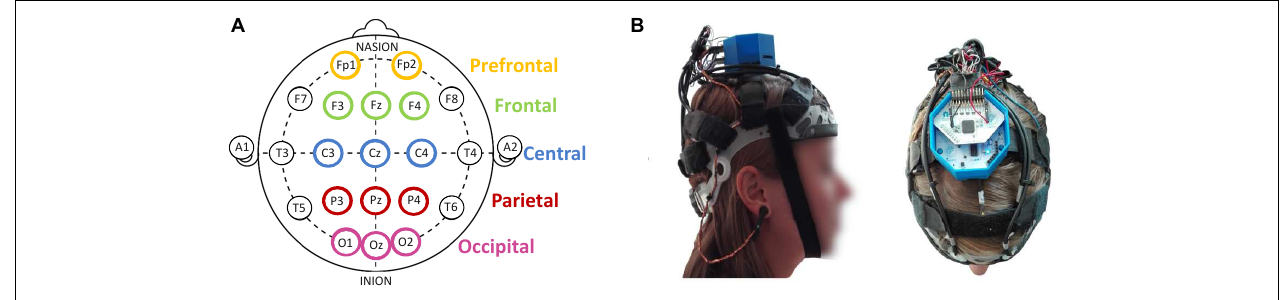
FIGURE 2 | Illustration of (A) electrode positioning based on a modified International 10–20 Electrode Placement System; (B) EEG headset (14 dry and active Conscious Labs electrodes (https://conscious-labs.com)) with the OpenBCI (http://openbci.com) acquisition card (right).